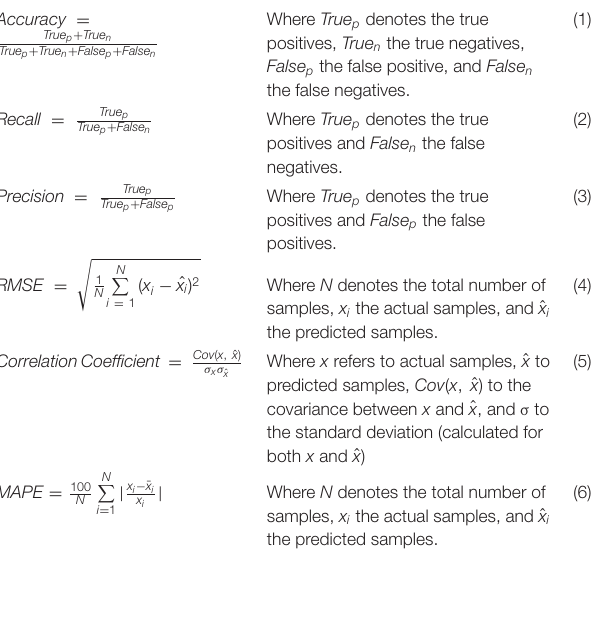
TABLE 7 | The main evaluation